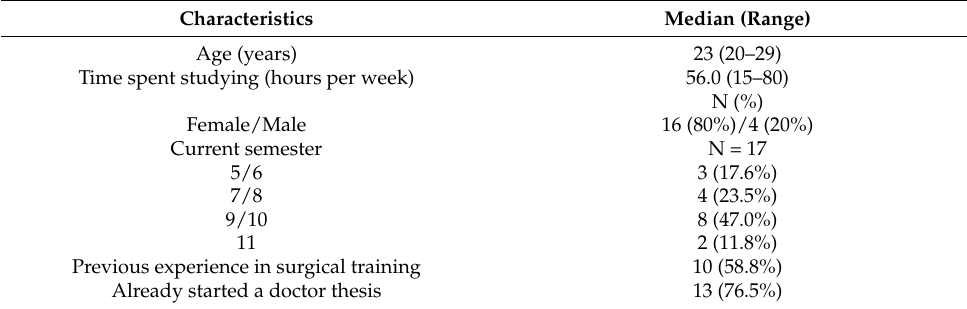
Table 1. Characteristics of the participating